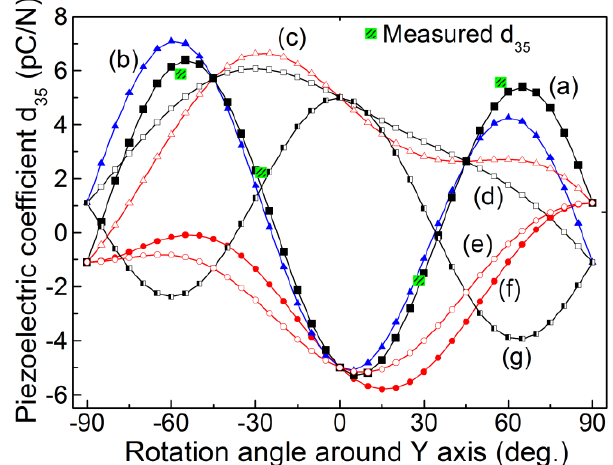
Figure 6. Variation of piezoelectric d as a function of rotation angle around the Y -axis for 35 YCOB crystals ((a) d , (b) presuming positive d , (c) presuming positive d 35 15 positive d , d , d and d , (e) presuming positive d and d , (f) presuming negative d 13 31 15 35 13 31 and (g) presuming positive d , d , d and d ). Reprinted with permission from 13 31 15 35